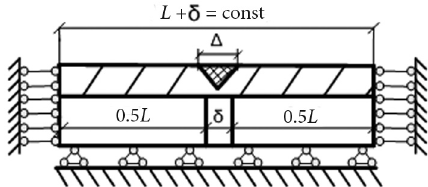
Fig. 12. Design model for the calculation of stresses in asphalt concrete pavement after the repair and re-crack formation after applying of a crack-interrupting layer and a wearing layer